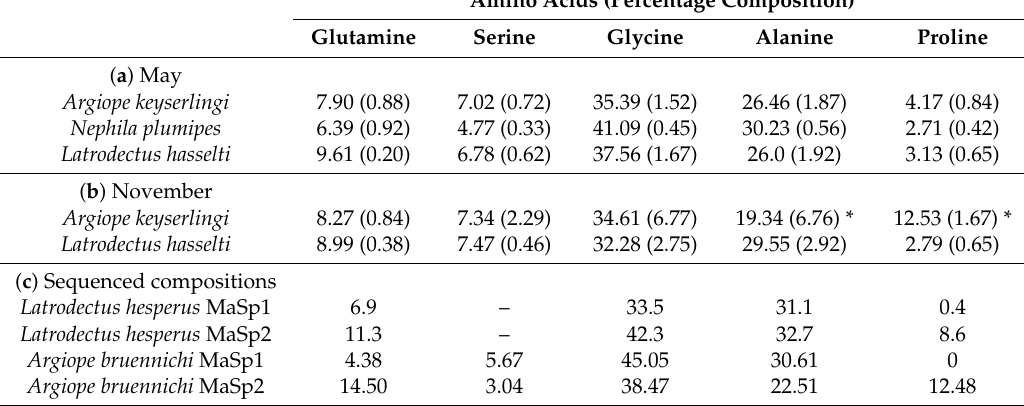
Table 1. Comparisons of: ( a ) The glutamine, serine, glycine, alanine and proline compositions (means with standard errors in parentheses) of L. hasselti , A. keyserlingi and N. plumpes dragline silks from spiders collected in May; ( b ) The glutamine, serine, glycine, alanine and proline compositions (means with standard errors in parentheses) of L. hasselti and A. keyserlingi dragline silks from spiders collected in November; ( c ) Compositions from dragline silk genetic sequences for Latrodectus hesperus (from reference [47]) and Argiope bruennichi [48]; * Indicates a statistically significant difference in composition was found between for silks collected in November compared to silks collected in May. Amino Acids (Percentage Composition) Glutamine Serine Glycine Alanine